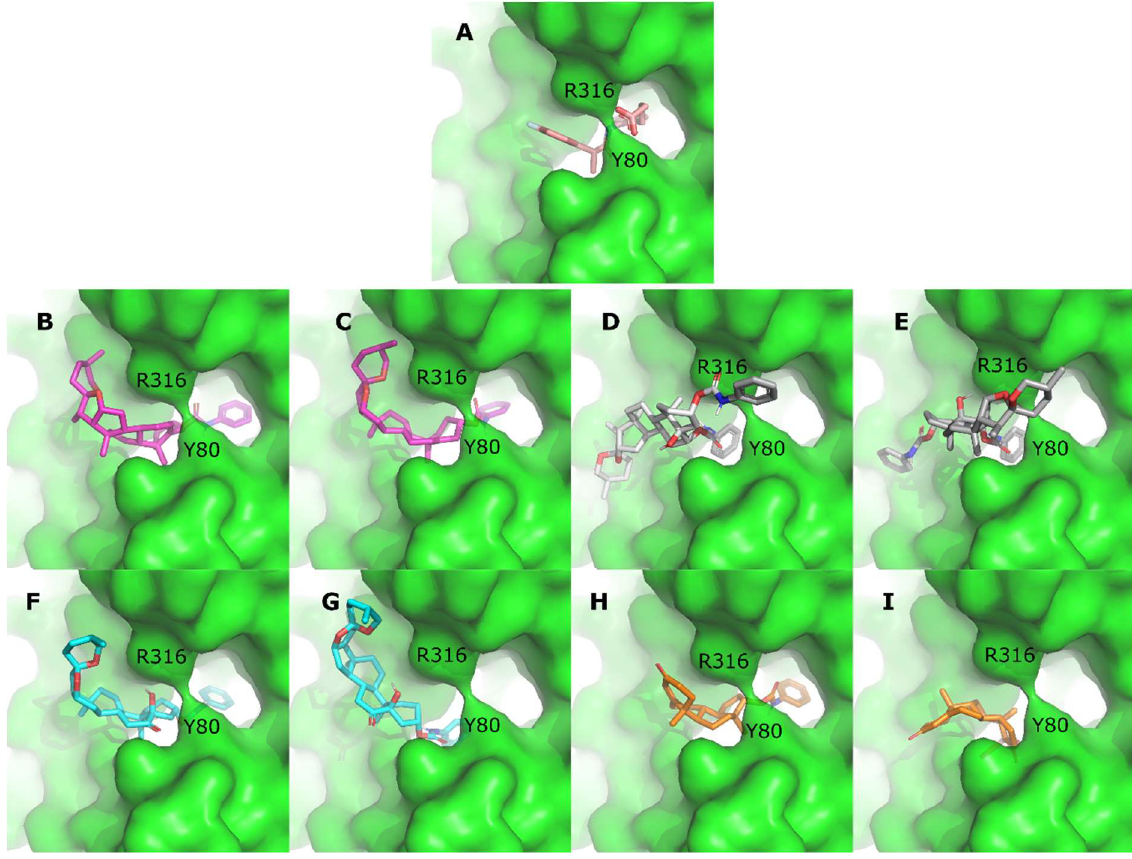
Figure 7. Binding modes of ( A ) ONO-AE3-208, ( B ) 4 (1), ( C ) 4 (2), ( D ) 5 (1), ( E ) 5 (2), ( F ) 6 (1), ( G ) 6 (2), ( H ) 7 (1), and ( I ) 7 (3) within the active site of EP4.